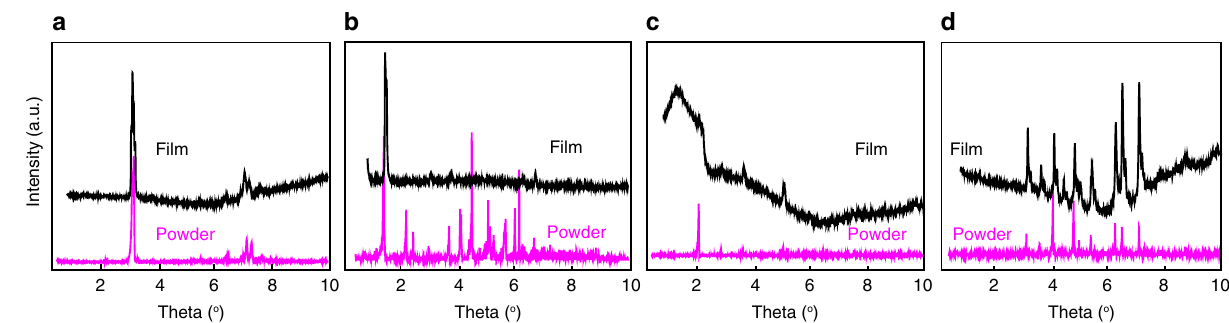
Fig. 5 Structural characterization of drug powders and deposited fi lms. X-ray diffraction patterns of: ( a ) caffeine, ( b ) tamoxifen, ( c ) BAY